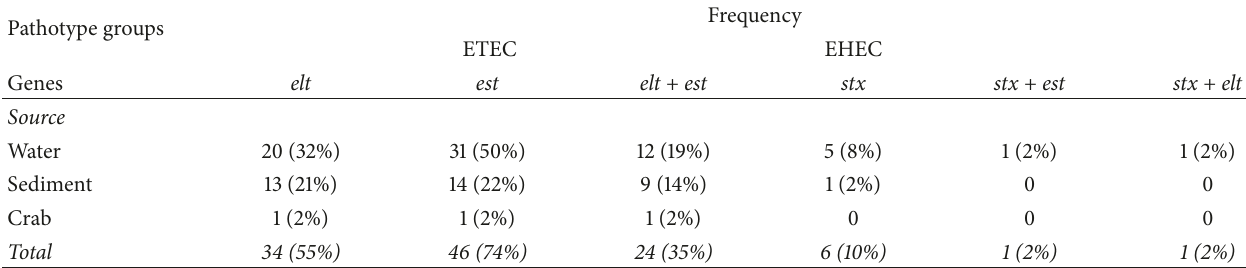
Table 4: Prevalence of virulence genes.